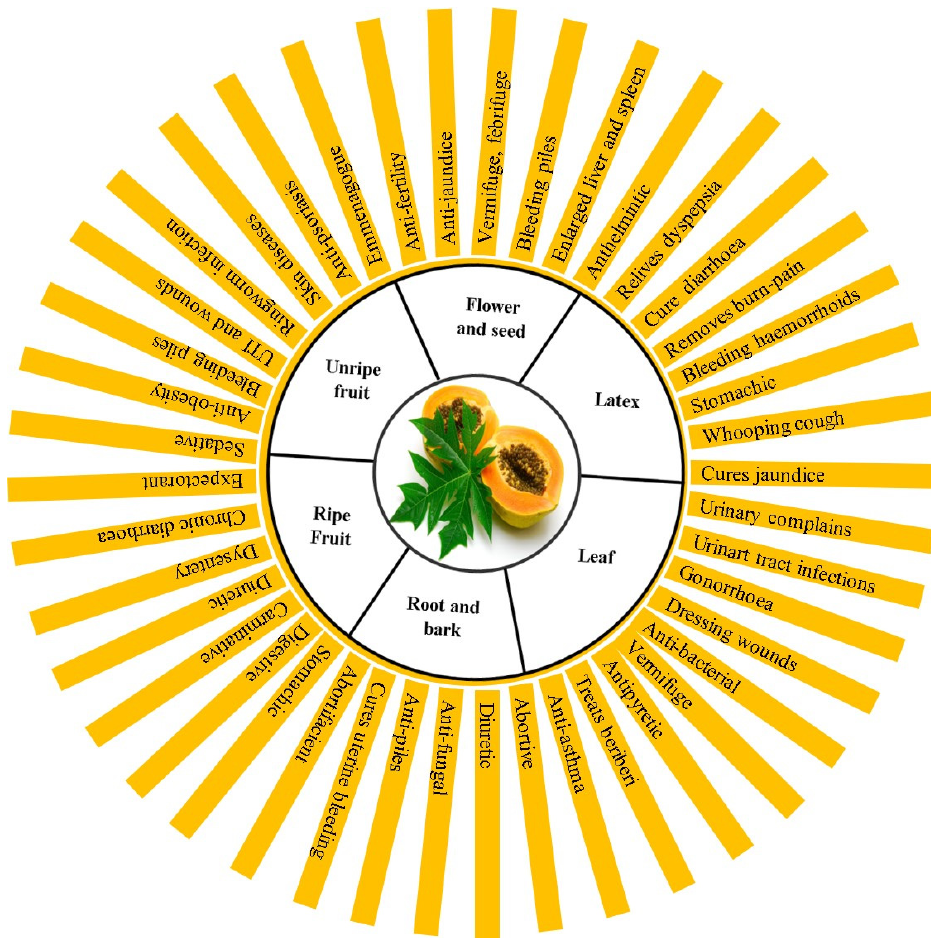
Figure 2. Health benefits of papaya ( Carica papaya L.) plant parts.